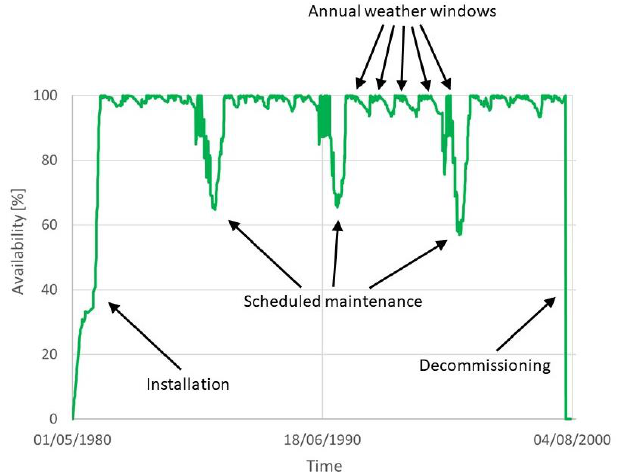
Fig. 22. Time series of availability over the life of the farm and its main characteristics.